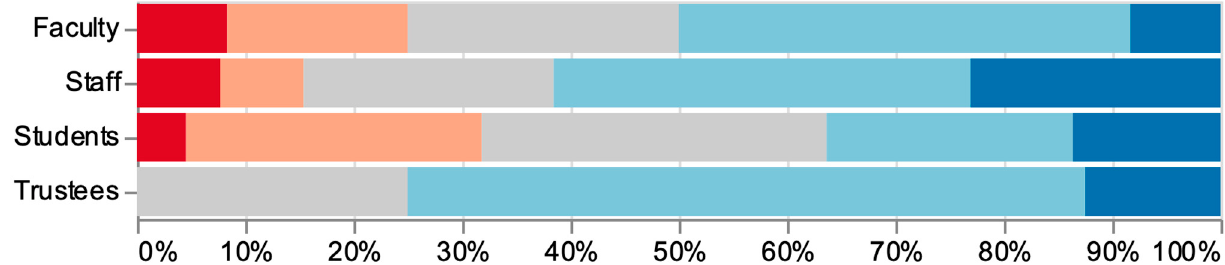
Figure 6. “Bivocational ministry is more stressful than fully-funded ministry”. (Q4). 5% strongly disagree; 16% disagree; 27% neutral; 36% agree; 15% strongly agree.